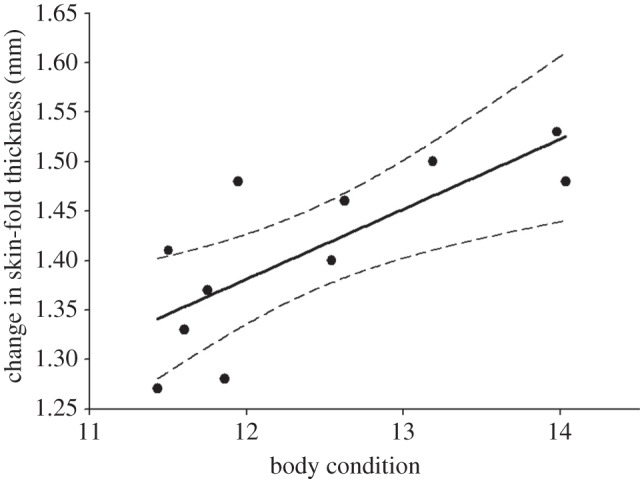
Relationship between change in PHA-induced skin-fold thickness and body condition of two-month-old California sea lion pups. Adjusted r2=0.53, p=0.006. Dotted lines represent 95% CIs.